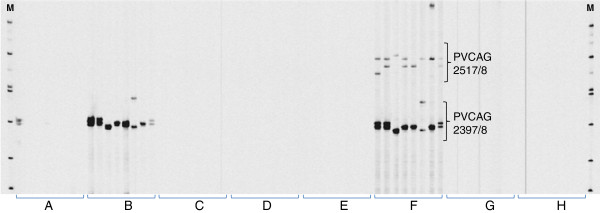
Optimization of duplex PCR. Alleles were amplified with a duplex set of SSR primer pairs (PVCAG-2517/8 and PVCAG-2397/8). Eight switchgrass genotypes from Alamo and Kanlow were used as amplification templates. The adjustments of PCR reaction components were shown from group A to H. Group A: control PCR with the same conditions as monoplex PCR, except for mixing PVCAG-2517/8 and PVCAG-2397/8 together; B: doubling Taq polymerase; C: doubling dNTPs concentration; D: doubling concentrations of DNA templates; E: increasing buffer concentration to 1.6x; F: increasing Mg 2+ concentration to 2.4 mM; G: doubling IR-M13 dye; H: doubling primer concentrations of PVCAG-2517/8 and PVCAG-2397/8. “M” indicated the DNA ladder.